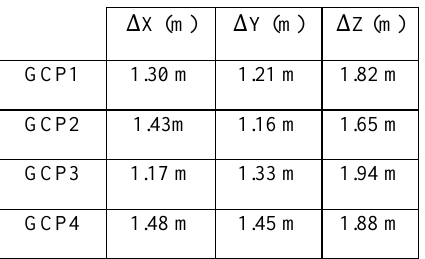
Table 2. Differences between known GCPs and calculated